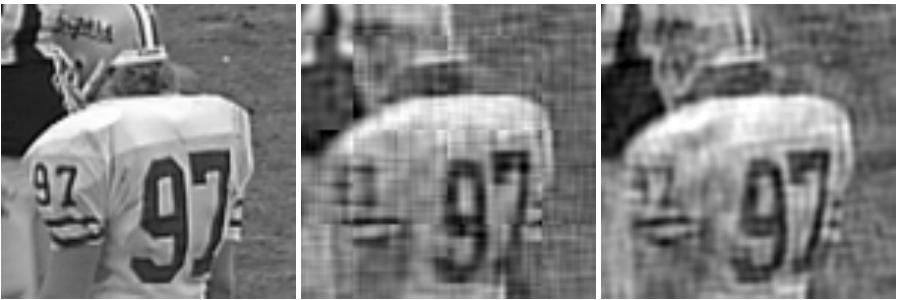
Figure 18. Zoom detail from Figure 17. “Football” frames received from a transmission of a video with a bandwidth ratio of 0.1 and SNR = 10dB. Left-hand side : original. Center : JSCC-Cast with SSIM quality of 0.66. Right-hand side : Softcast with SSIM quality of 0.66.